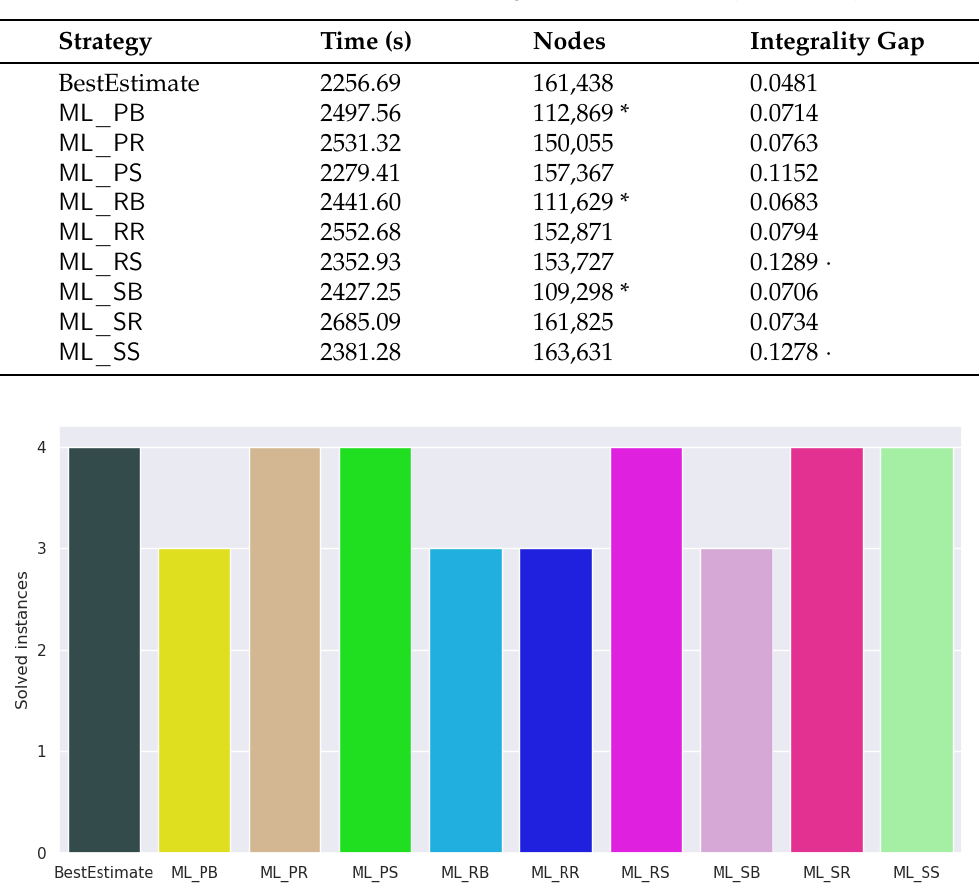
Figure 6. Hard set cover instances: number of solved instances (out of 10) for each node selection strategy.